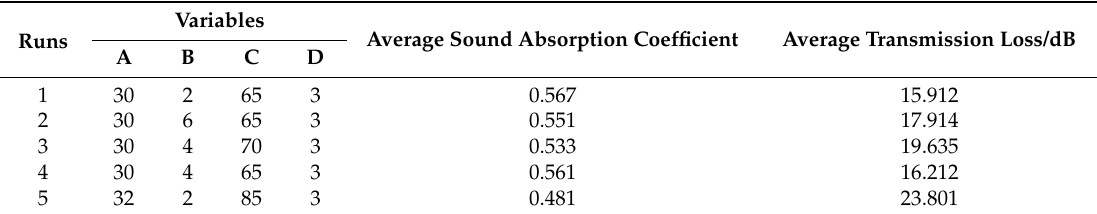
Table 6. Experimental sample for accuracy evaluation of surrogate models.